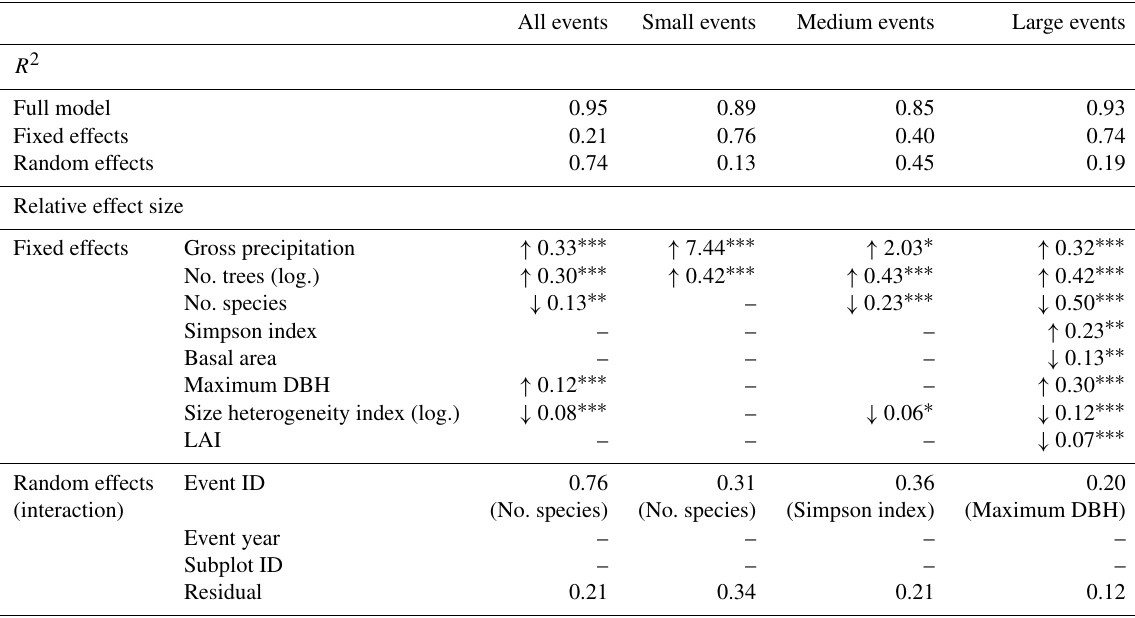
Table 5. Results of the linear mixed effects models for subplot stemflow: slope estimates and significance levels of significant fixed effects, standard deviations of random effects and their interacting fixed effects (random slopes). The four models include (i) all precipitation events, (ii) small precipitations events with less than 5mm of rainfall, (iii) medium precipitation events with between 3 and 10mm of rainfall and (iv) large precipitation events with rainfall more than 10mm of rainfall. Pseudo- R 2 values are given for each full model (fixed and random effects), for the fixed effects model separately and for the random effects model separately. Note that data were scaled before model